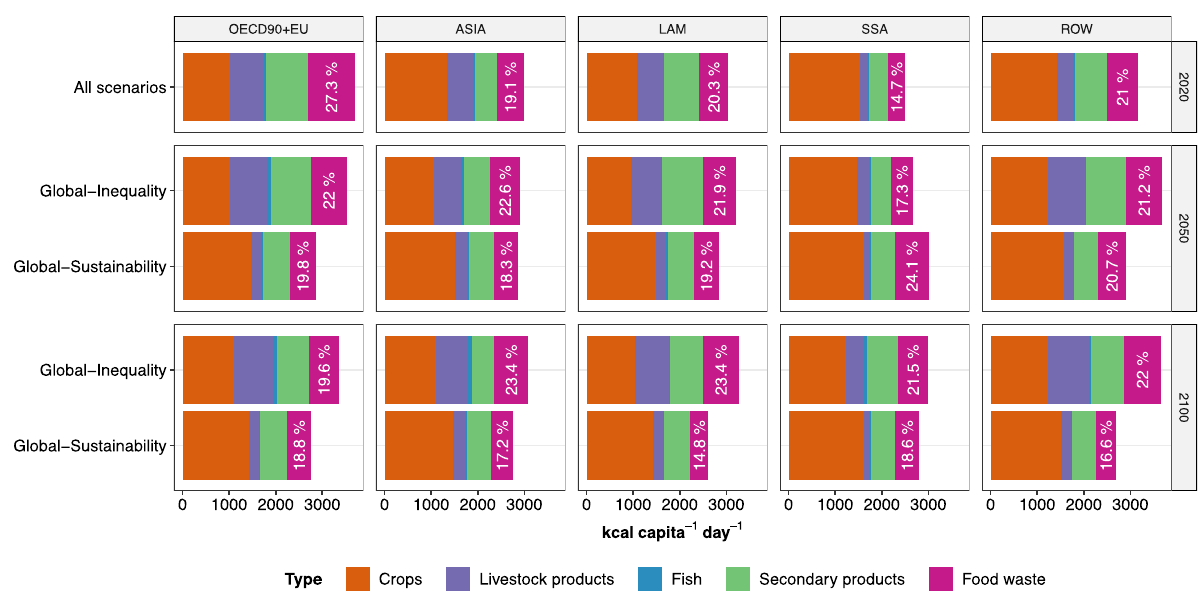
Fig. 2 | Per-capita calorie supply. The sum of crops, livestock products, fi sh, and secondary products re fl ects food intake, which together with food waste sums up tofoodsupply.Percentagevaluesindicatetheshareoffoodwasteinthetotalfood